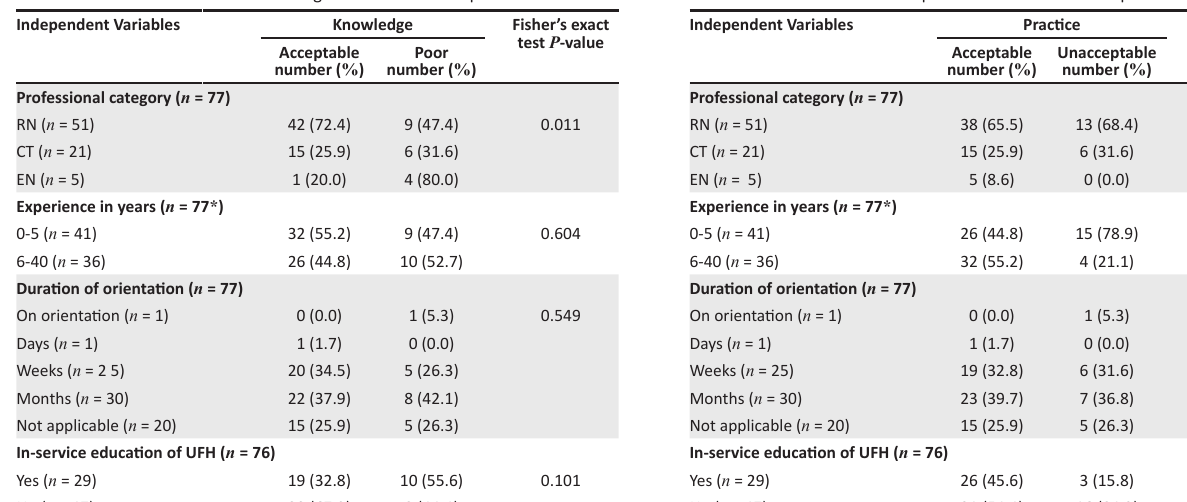
TABLE 6: Association between practice and selected independent